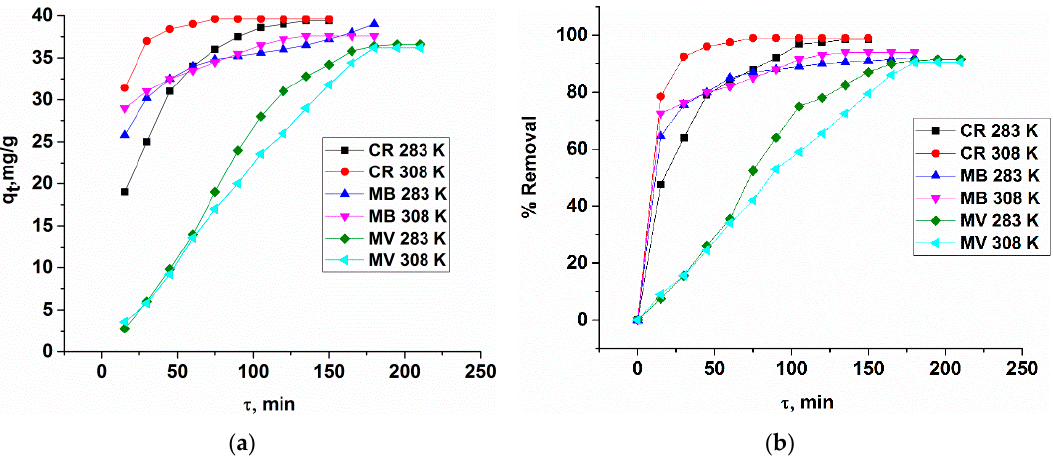
Figure 6. ( a ) Relationship between adsorbed quantities ( q t ) of the dyes and time. ( b ) E ff ect of contact time on the removal of the organic dyes by Cu 3 (BTC) 2 · H 2 O.